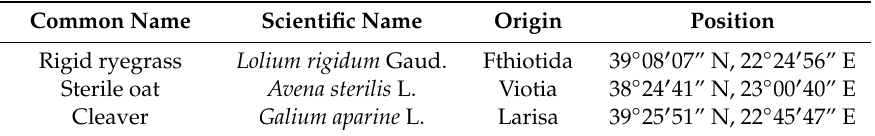
Table 1. Weed species studied, origins and geographical positions where seed collection was carried